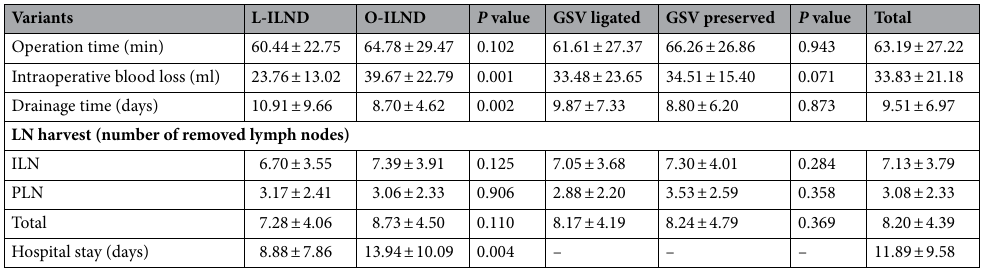
Table 2. Perioperative details for ILND treated patients. L‑ILND laparoscopic inguinal lymph node dissection, O‑ILND open inguinal lymph node dissection, GSV great saphenous vein, PLND pelvic lymph node dissection. Operative time, blood loss, drainage time, GSV preservation, PLND performed, and the number of LNs harvested were analyzed for different surgical types (80 L-ILND cases and 138 O-ILND cases, respectively). Postoperative hospital stay was analyzed for patients treated by different techniques (40 cases of L-ILND and 69 cases of O-ILND, respectively).